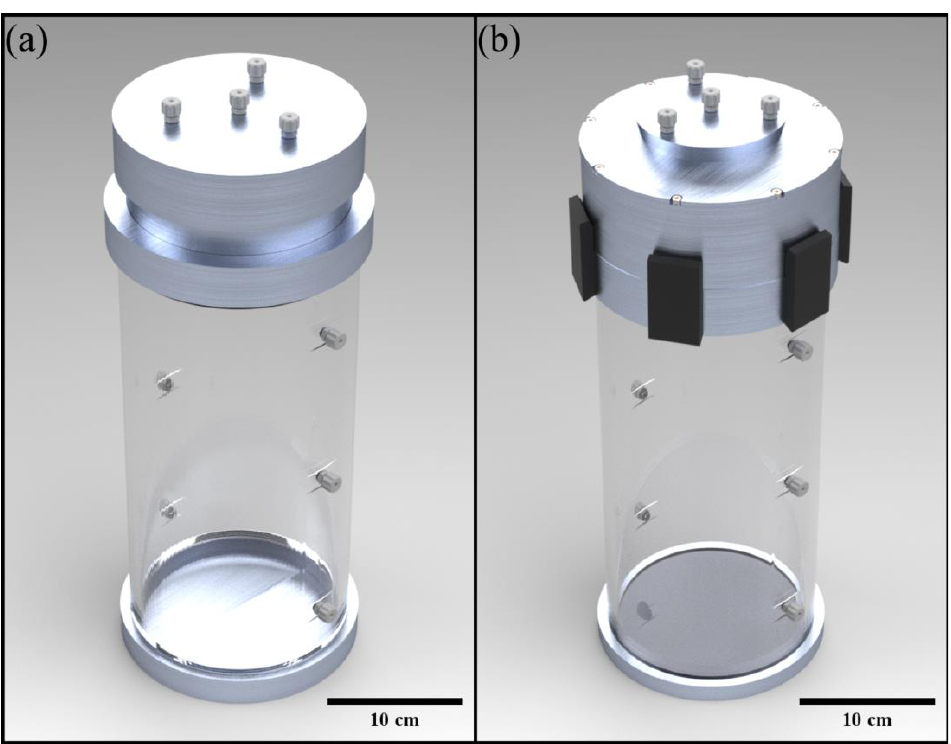
Figure 1. ( a ) A render of the original iteration of VOPS. ( b ) The redesigned version of the VOPS device.